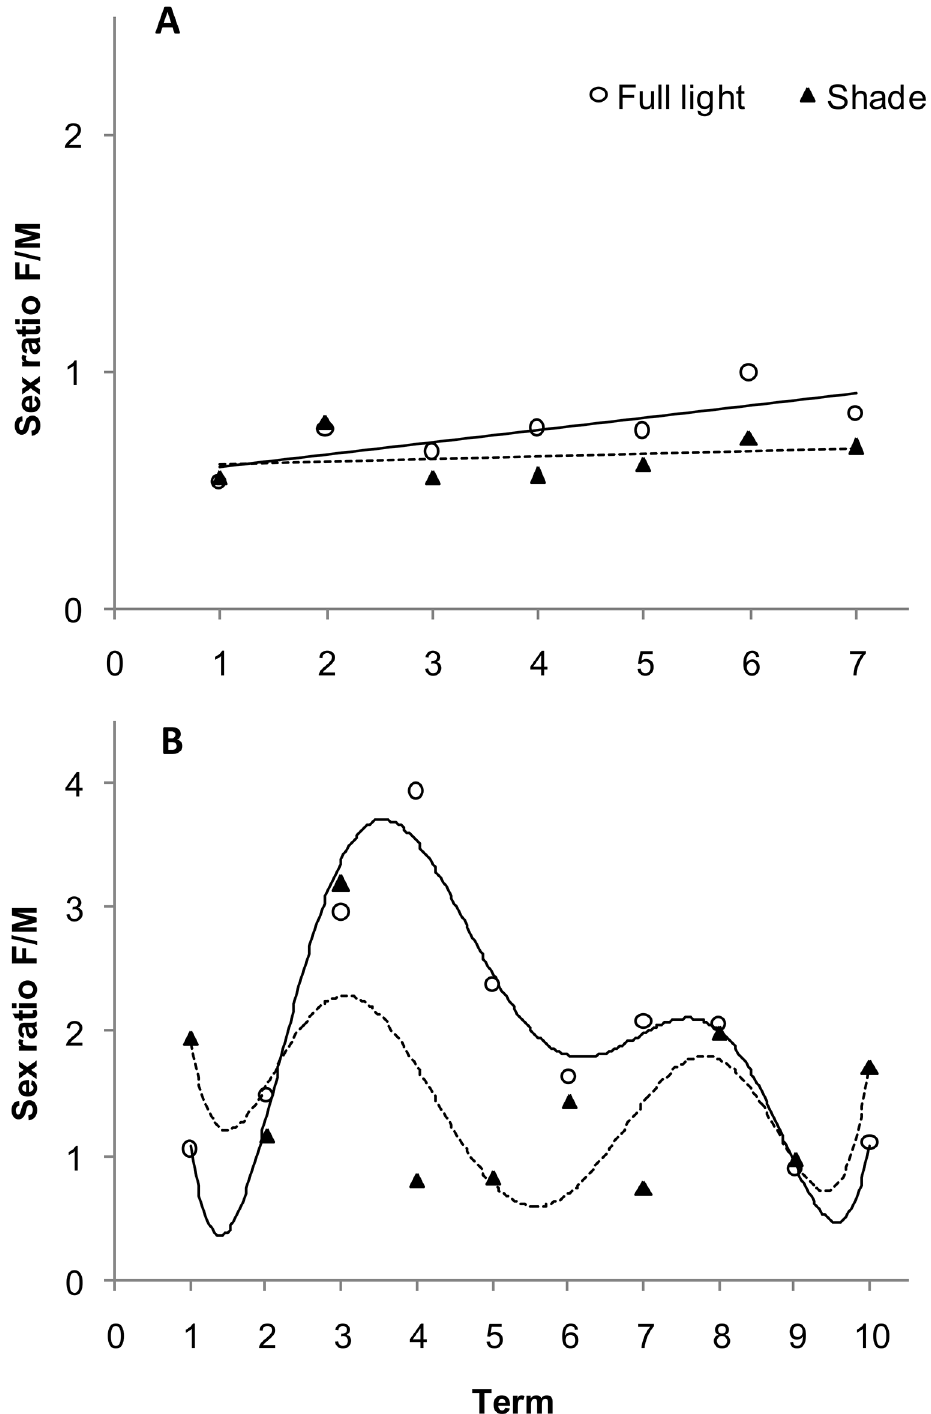
Fig 6. Sex ratio of current-year (A) and 1-year-old (B) Altica brevicollis coryletorum beetles on shrubs growing in full light and shaded conditions over time. Numbers 1 – 7 (for current-year) and 1 – 10 (for 1-year-old) indicate successive dates of insect collection (see Materials and Methods). One-way ANOVA was used to determine the effect of term (length of the sampling period) on current-year beetles (full light, R 2 = 0.2106, P = 0.4918; shade, R 2 = 0.0754, P = 0.9374) and 1-year-old beetles (full light, R 2 = 0.5475, P = 0.0018; shade, R 2 = 0.2715, P =